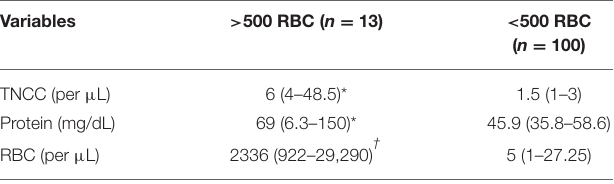
TABLE 5 | Comparison of fluid analysis parameters in blood admixed vs. non-blood admixed samples using an objective cutoff ( > 500 RBC/ µ L and < 500 RBC/ µ L).